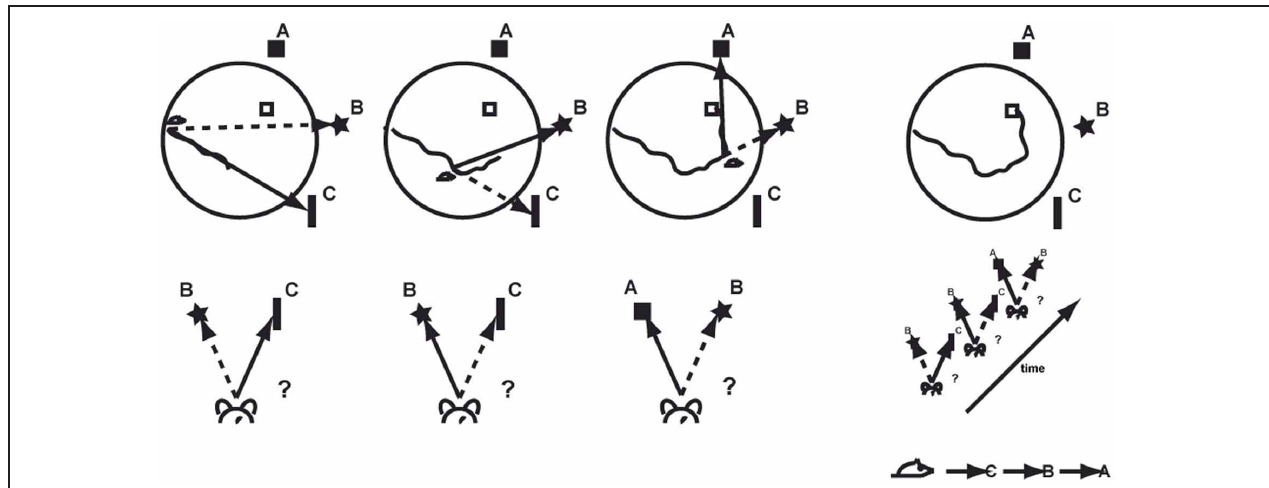
FIGURE 2 | Associating specific places or spatial contexts with moving directions allows learning effective routes to find the hidden goal. A, B, and C represent different stable visual